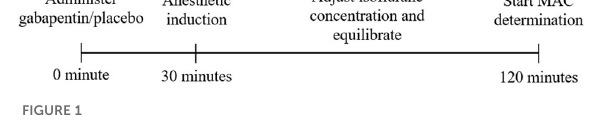
FIGURE1 Study timeline. After 30min of oral administration of the gabapentin capsule or empty capsule, anesthesia was induced in all cats. Isoflurane concentration was adjusted to maintain a light surgical depth of anesthesia and cats were allowed to equilibrate at